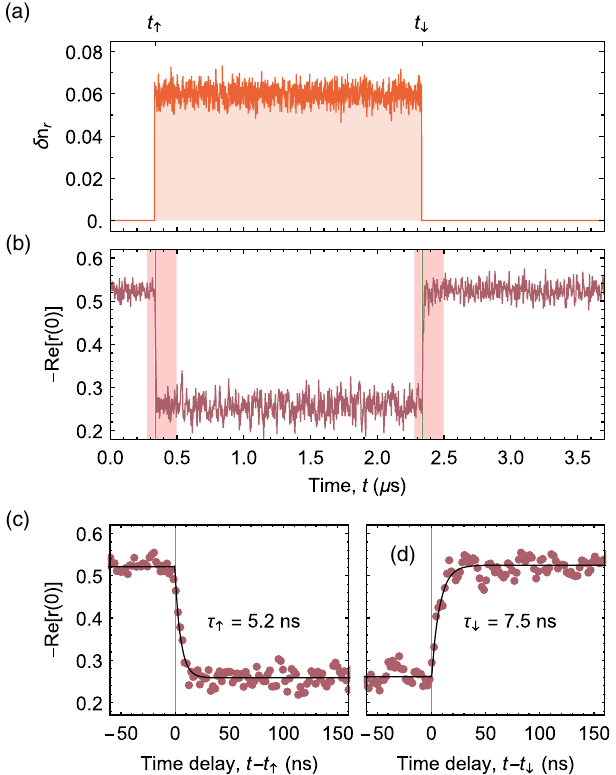
FIG. 10. Temporal response of the thermometer. (a) Photon occupation number of the applied noise pulse, δ n , vs time, r calibrated and averaged over noise realizations. (b) Measured real part of the reflection coefficient at resonance, − Re ½ r ð 0 Þ(cid:3) , vs time. Green vertical lines denote the start and end times of the noise pulse ( t ↑ and t ↓ , respectively). (c,d) Close-up of the shaded regions in panel (b) at the leading and trailing edges of the thermometer response (dots). The solid red lines are fits of a single exponential function to the data, giving a ring-up time τ ¼ 5 . 2 ns and a ring-down time τ ¼ 7 . 5 ↑ ↑